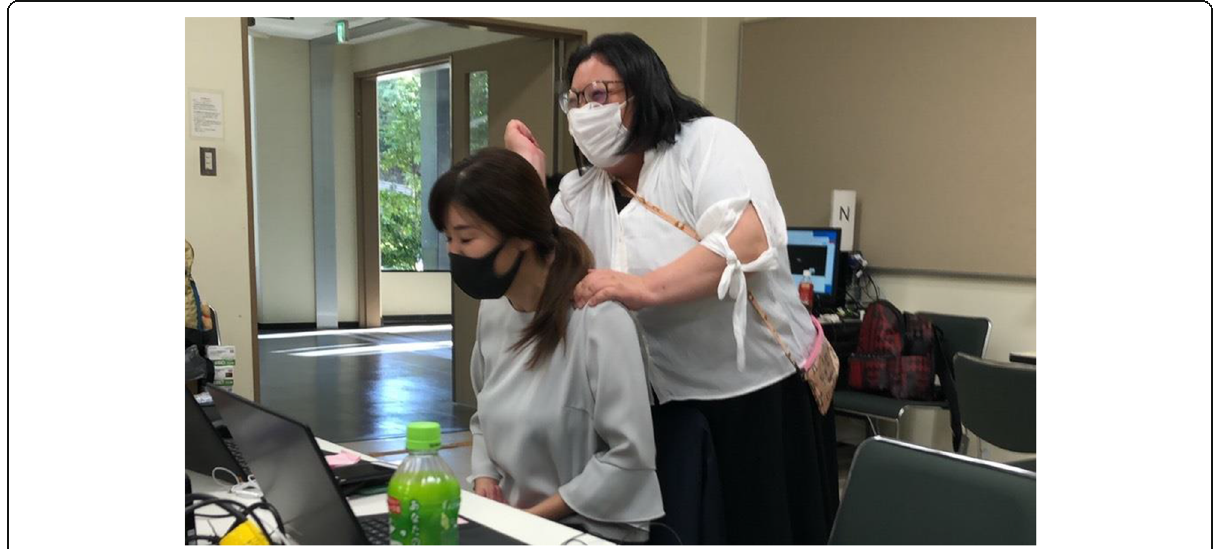
Fig. 4 Ms. Watanabe (Left) and Ms. Kita (Right) from the secretariat, during